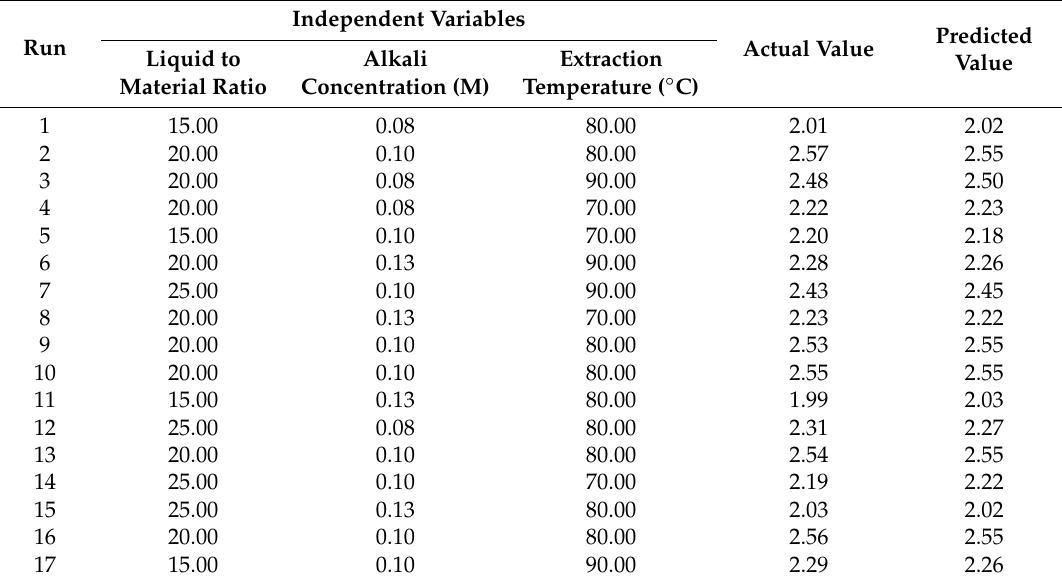
Table 1. Box–Behnken central composite design for independent variables and their responses.